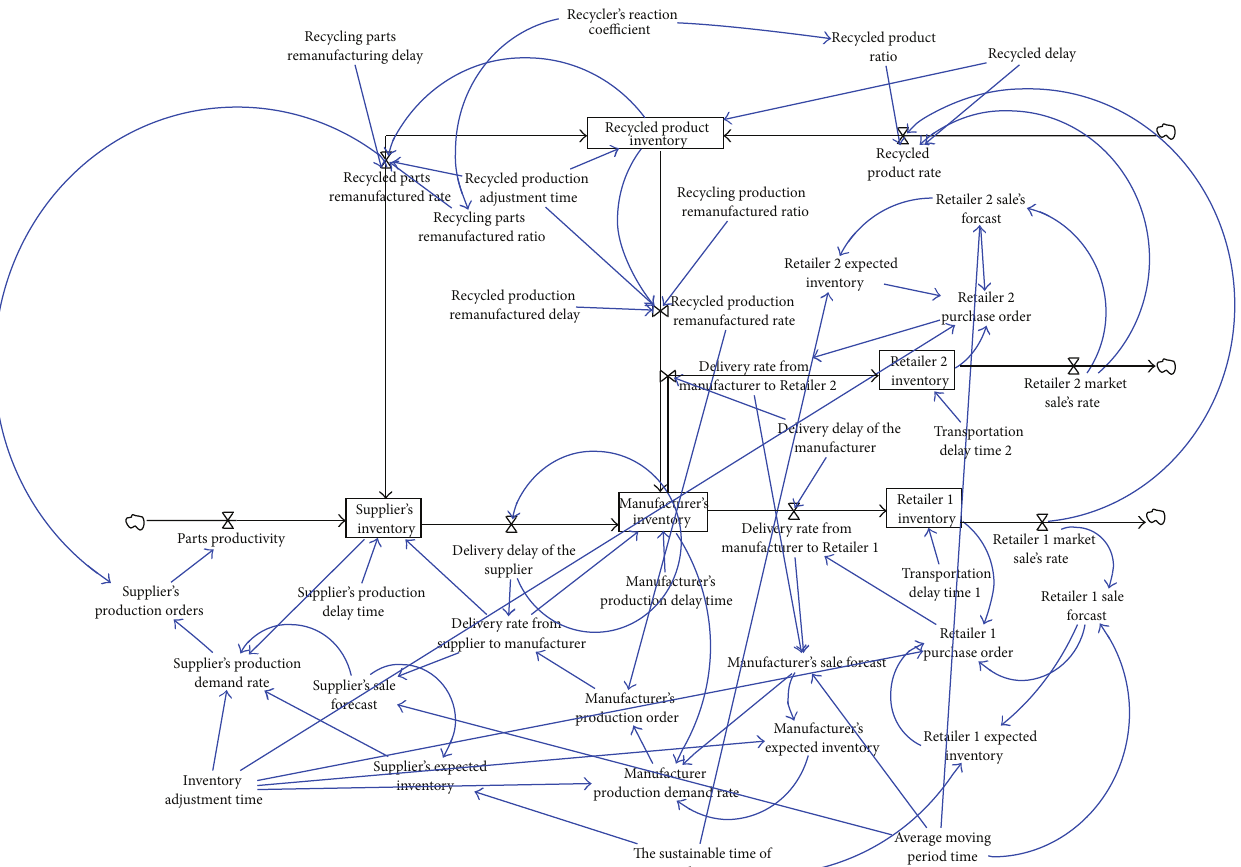
Figure 3: Closed-loop supply chain distribution network system dynamics flow